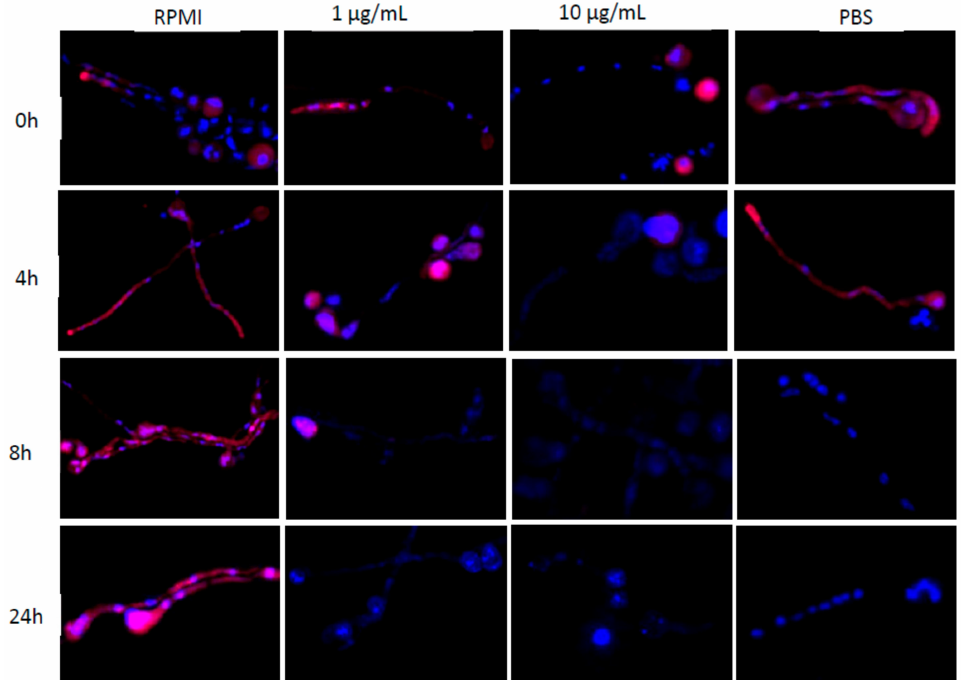
Figure 4. Nutrient deprivation and antifungal exposure reduce FISH signal of Mucorales hyphae. Hybridization of R. oryzae germlings with Mucorales-specific probes before and after exposure to amphotericin B (1 µ g/mL, second column or 10 µ g/mL, third column) or nutrient-limiting conditions (PBS) for up to 24 h. Positive hybridization signal of hyphae persists with continued incubation in RPMI (first